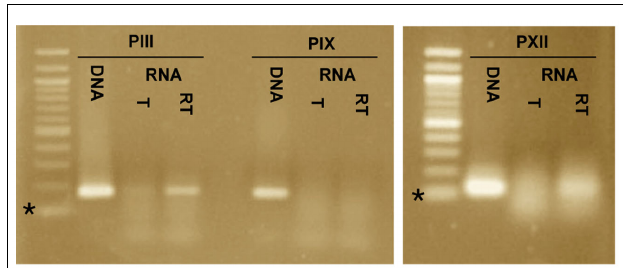
FIGURE 5 | Reverse-transcriptase polymerase chain reaction (RT-PCR) identifies transcripts downstream of promoter-trap-identified promoters PIII and PXII. RT-PCR was carried out for the three promoters that potentially directed expression of antisense transcripts, PIII, PIX, and PXII.Three reactions were included for each promoter, a DNA template + DNA polymerase (DNA), an RNA template + DNA polymerase (T) and an RNA template + reverse-transcriptase and DNA polymerase (RT). Amplicons of the correct size were detected for PIII and PXII in the RT reactions but not in theT reactions. An amplicon was not detected for PIX in the RT orT reactions.This supports expression of transcripts downstream of PIII and PXII, but not PIX.The ∗ indicates the 100-bp marker of the 100-bp ladder.